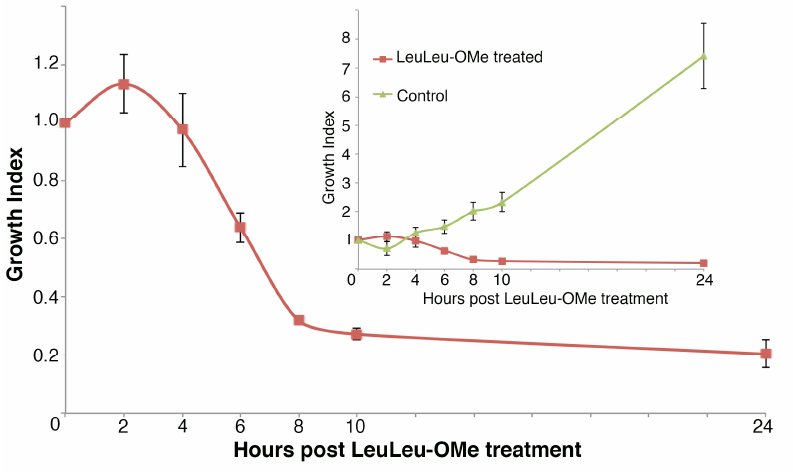
FIGURE 1: Cytotoxicity of LeuLeu-OMe to bloodstream form T. brucei. Cells were incu- bated with or without 30 µM LeuLeu-OMe for up to 24 h. Samples were taken at the indi- cated time points and monitored for cell growth. Decreased cell number was observed after 2 h of LeuLeu-OMe treatment, while control cells continued to proliferate (see inset for comparison). Growth index was calculated as described in Methods. The re- sults were presented as mean ± SD from 3 independent